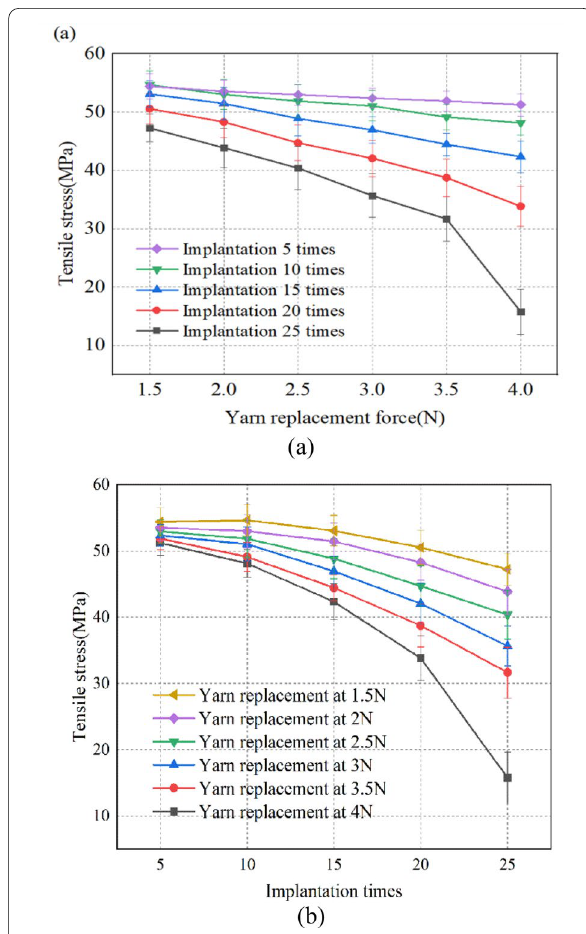
Figure 16 Fiber fracture strength as a function of preform position and friction number